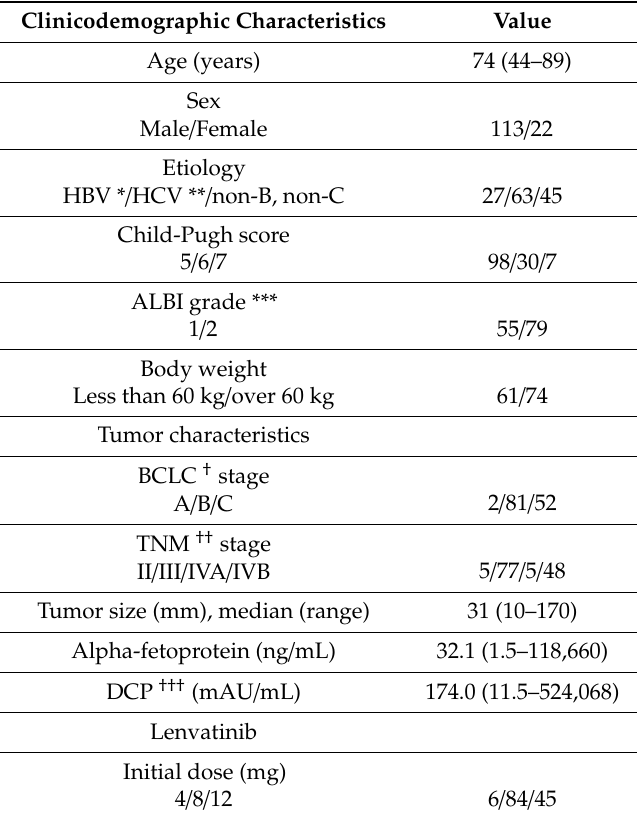
Table 1. Baseline clinical demographic and tumor characteristics of the patients ( n = 135